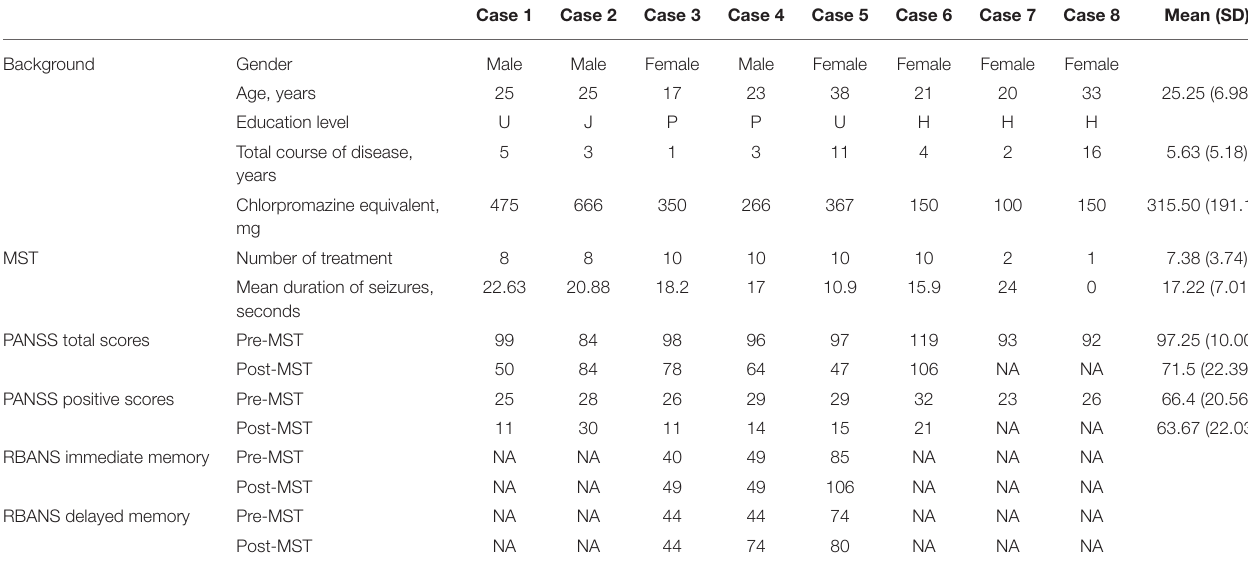
TABLE 1 | Characteristics of participants.